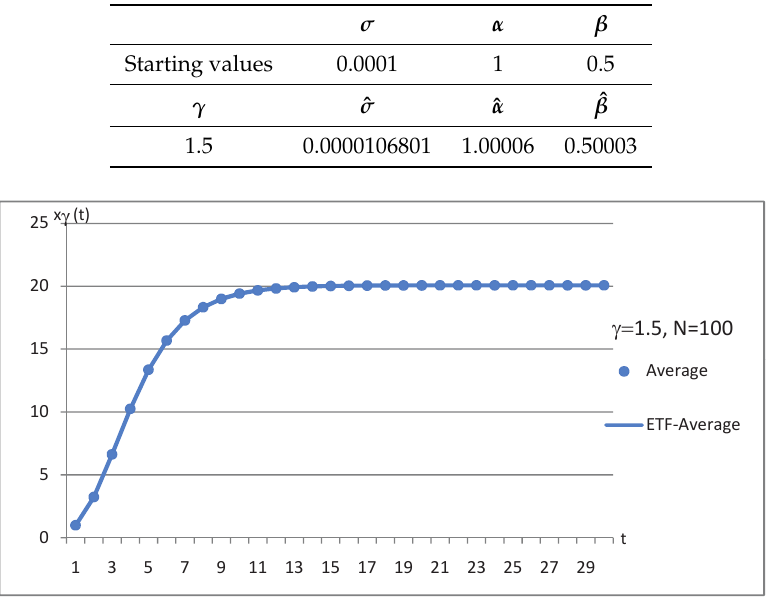
Table 3. Starting values used in the simulation and estimation of the parameters.